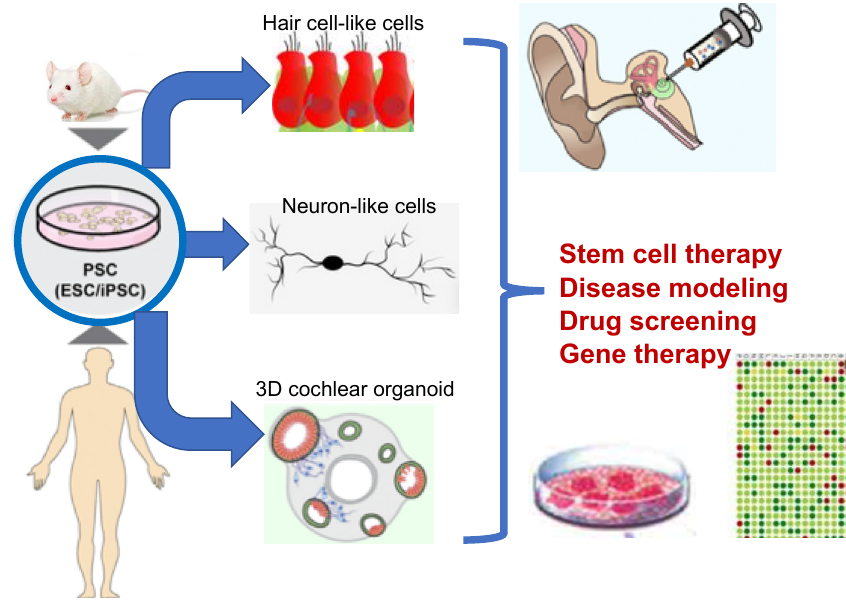
Figure 5. Stem cell applications. Mouse- and human-derived embryonic and induced pluripotent stem cells can be reprogramed in order to generate sensory cells and neurons for stem cell therapy and cochlear organoids for in vitro analyses (adapted from [80]). PSC: pluripotent stem cell.